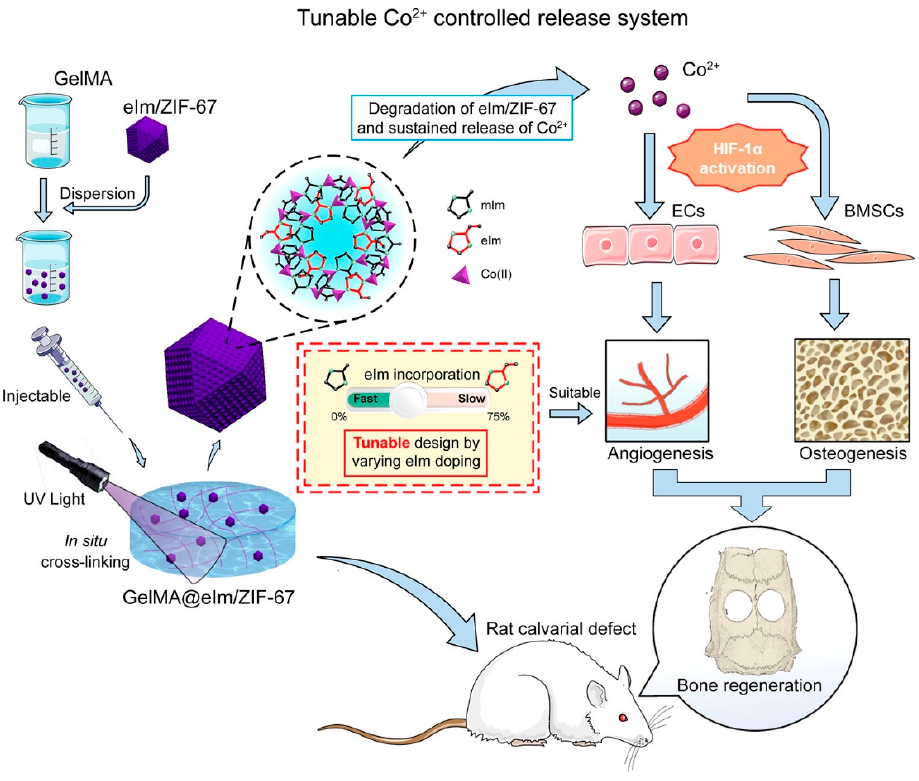
Figure 9. Schematic illustration of the GelMA@elm/ZIF-67 nanocomposite hydrogel, the delivery of Co ions, and the mechanism for angiogenesis and osteogenesis. Reprinted with permission from [97]. However, the effects of light intensity, duration, and reactive intermediates on the physiological behaviors of the organisms still need to be evaluated through